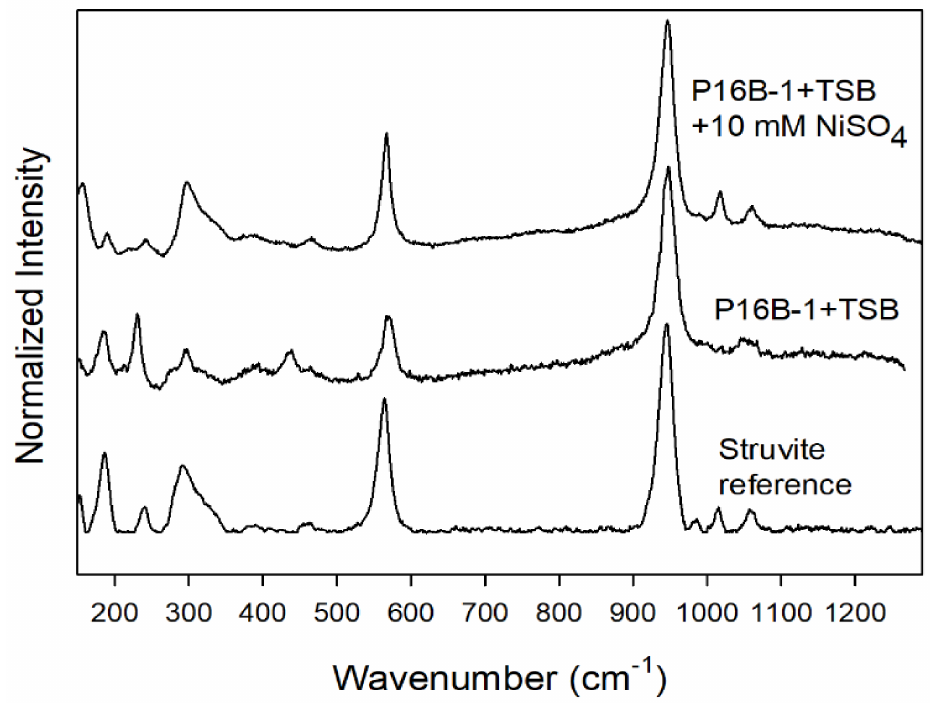
Figure 3. Identification of struvite by comparison of Raman spectra of crystals produced on TSB medium with or without nickel addition by S. mirabilis P16B-1, compared to struvite spectrum available in RRUFF database. For comparison, we have rescaled the spectra by normalizing the strongest Raman band at 946 cm − 1 to an intensity value of